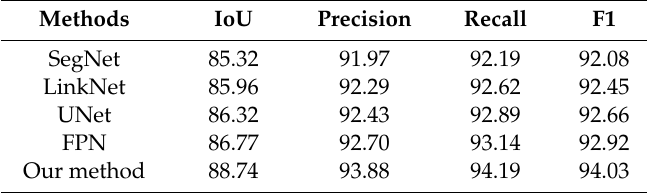
Table 4. Accuracy of each method on the Shanghai Distributed Photovoltaic Power Station data set